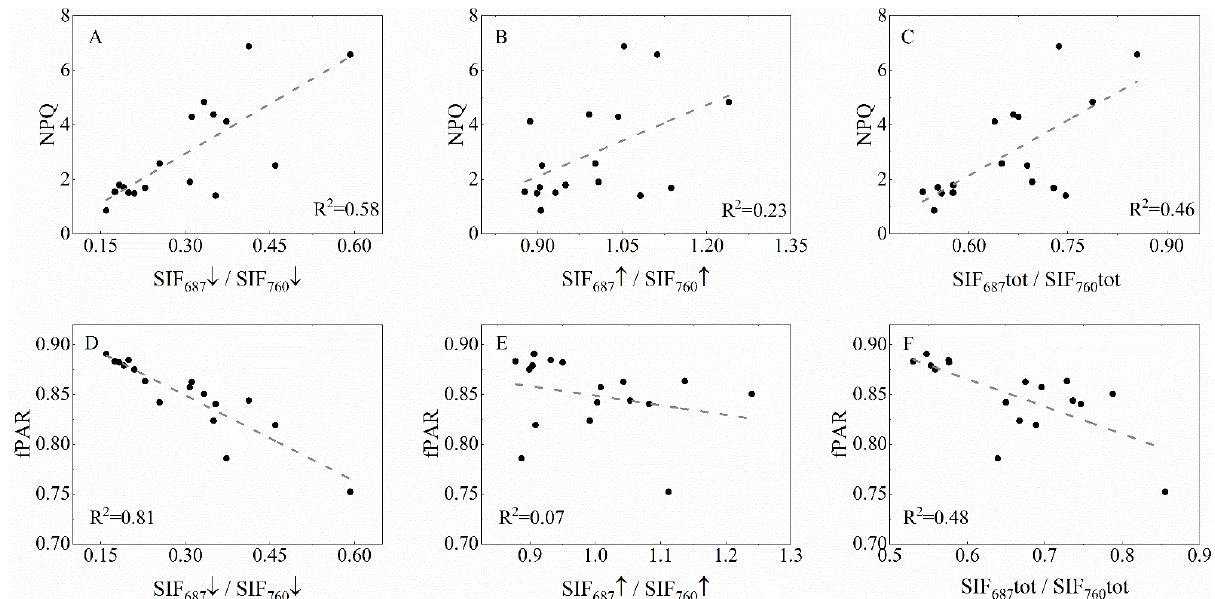
Figure 5. Linear relationships between the red (687 nm): far-red (760 nm) SIF ratio and NPQ for downward ( A ), upward ( B ) and total SIF ( C ). Linear relationships between the red (687 nm): far-red (760 nm) SIF ratio and fPAR for downward ( D ), upward ( E ) and total SIF ( F ). Here, total SIF is calculated as the sum of downward and upward SIF, and fPAR is used to represent the chlorophyll content of leaves.